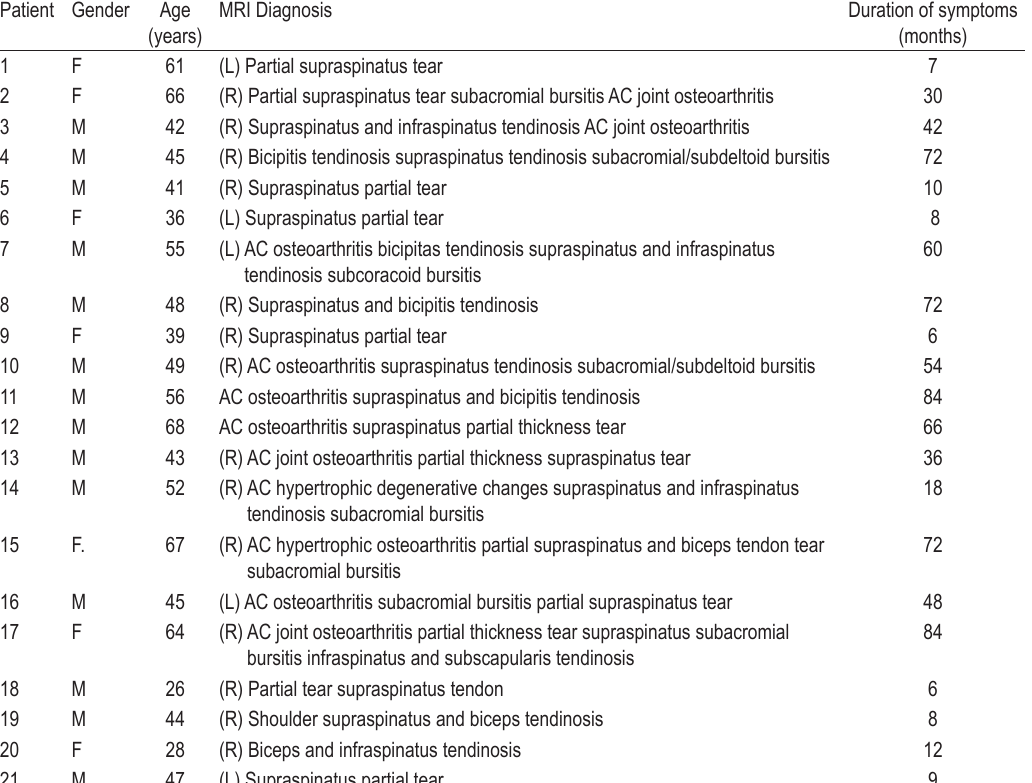
TABLE 2. Patients with rotator cuff tendinopathy treated with dextrose Prolotherapy Patient Gender Age